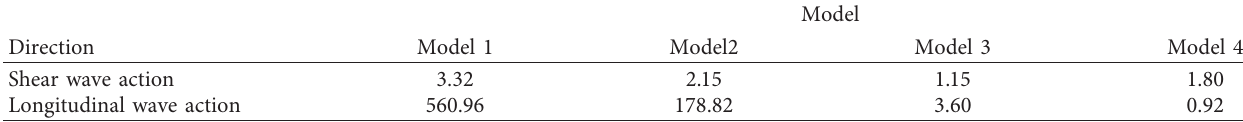
Table 4: Calculation result of the stability factor.